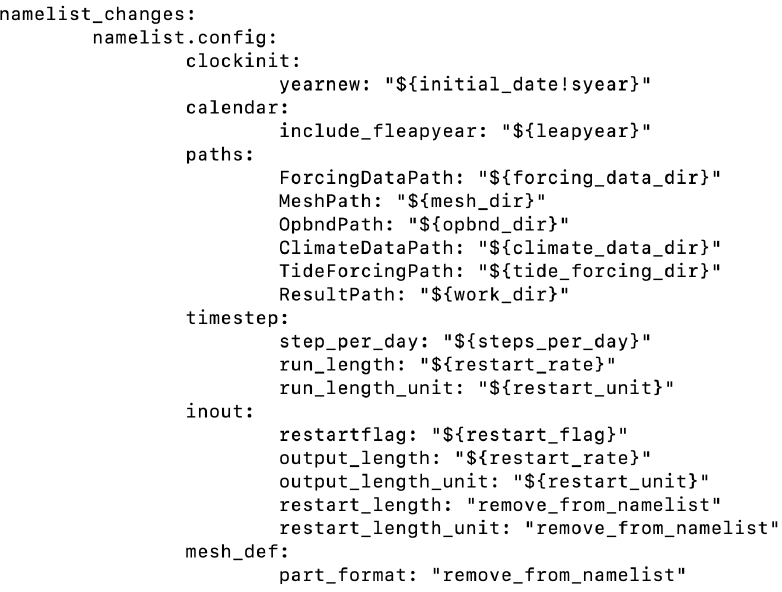
Figure 9. Excerpt from fesom.yaml with the information on how to compile and download fesom-1.4 .